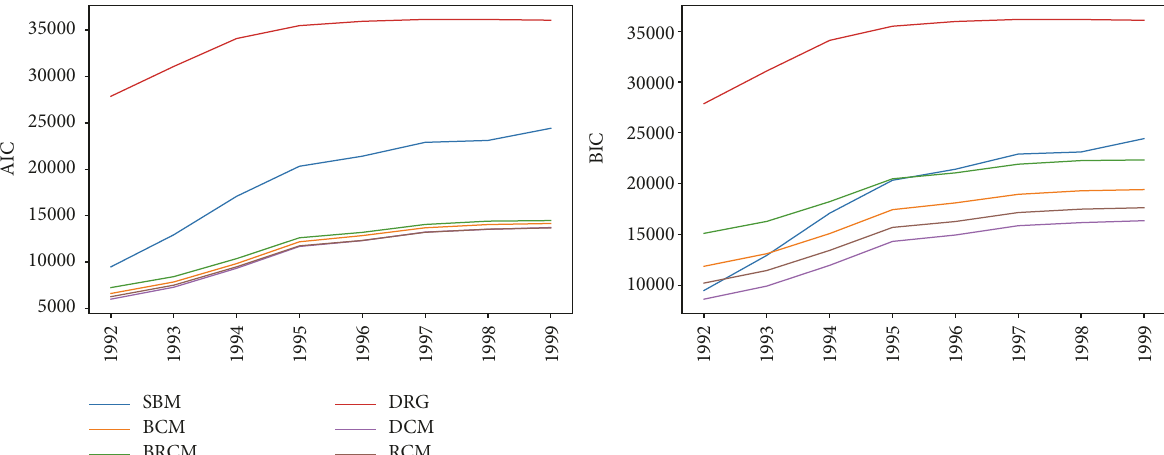
Figure 3: Evolution of the AIC and BIC values for the WTW across the years 1992-2002: while the SBM (blue trend) must be preferred to the traditional DRG (being the network composed by parts with different link densities), heterogeneous benchmarks are, generally speaking, to be preferred. Although the DCM and the RCM are characterized by very similar AIC values, AIC and BIC weights let always the DCM win. The ddc-SBM experiences convergence problems throughout the entire temporal